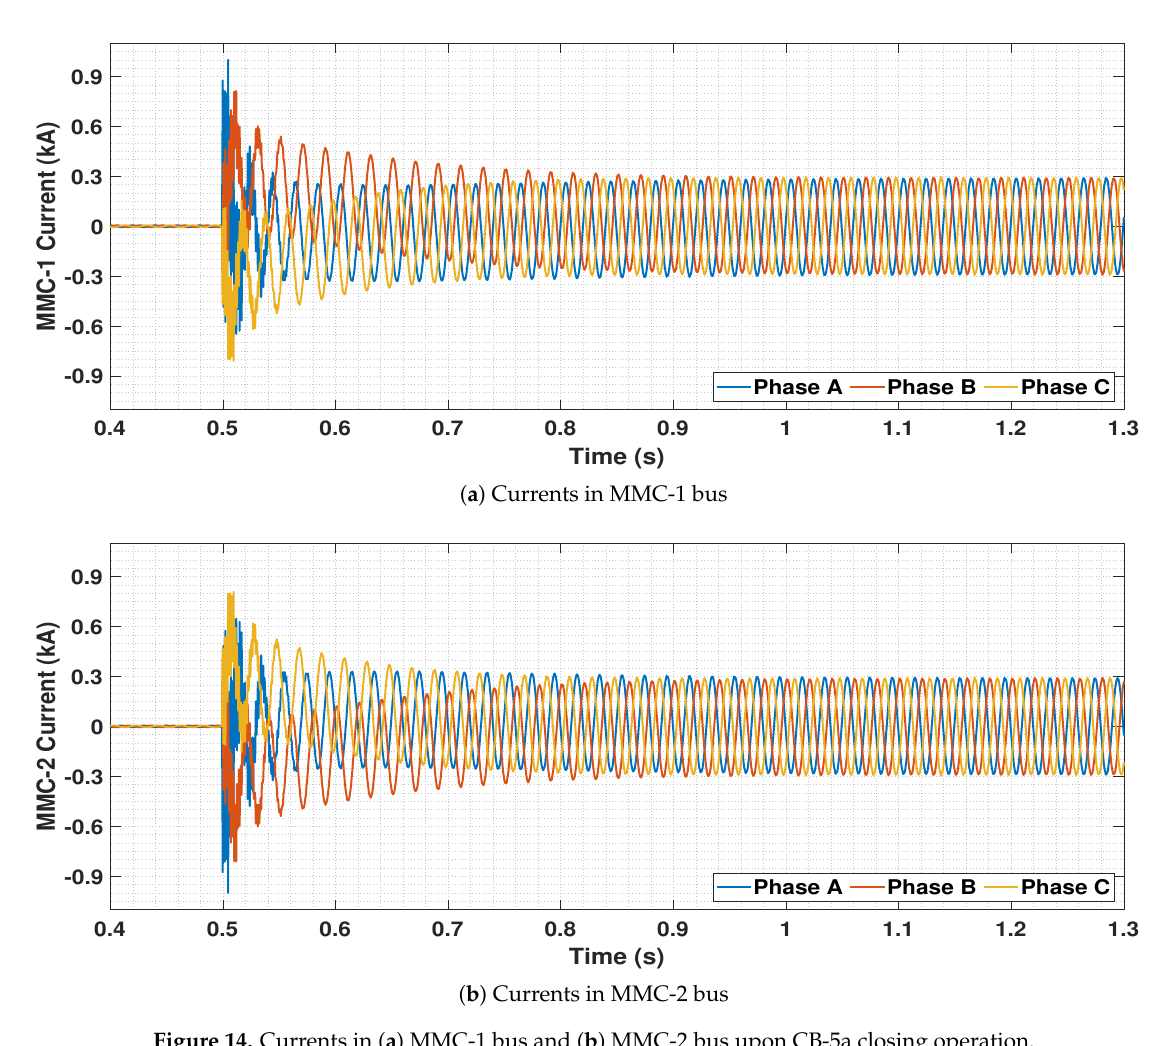
Figure 14. Currents in ( a ) MMC-1 bus and ( b ) MMC-2 bus upon CB-5a closing operation. The next step is to close the circuit breaker, CB-6a to connect MMC-2 to the network and hence, synchronize it with MMC-1. The voltage at the MMC bus remains the same after connecting MMC-2, as shown in Figure 15. Reason for that is the voltage reference provided and maintained by MMC-1.